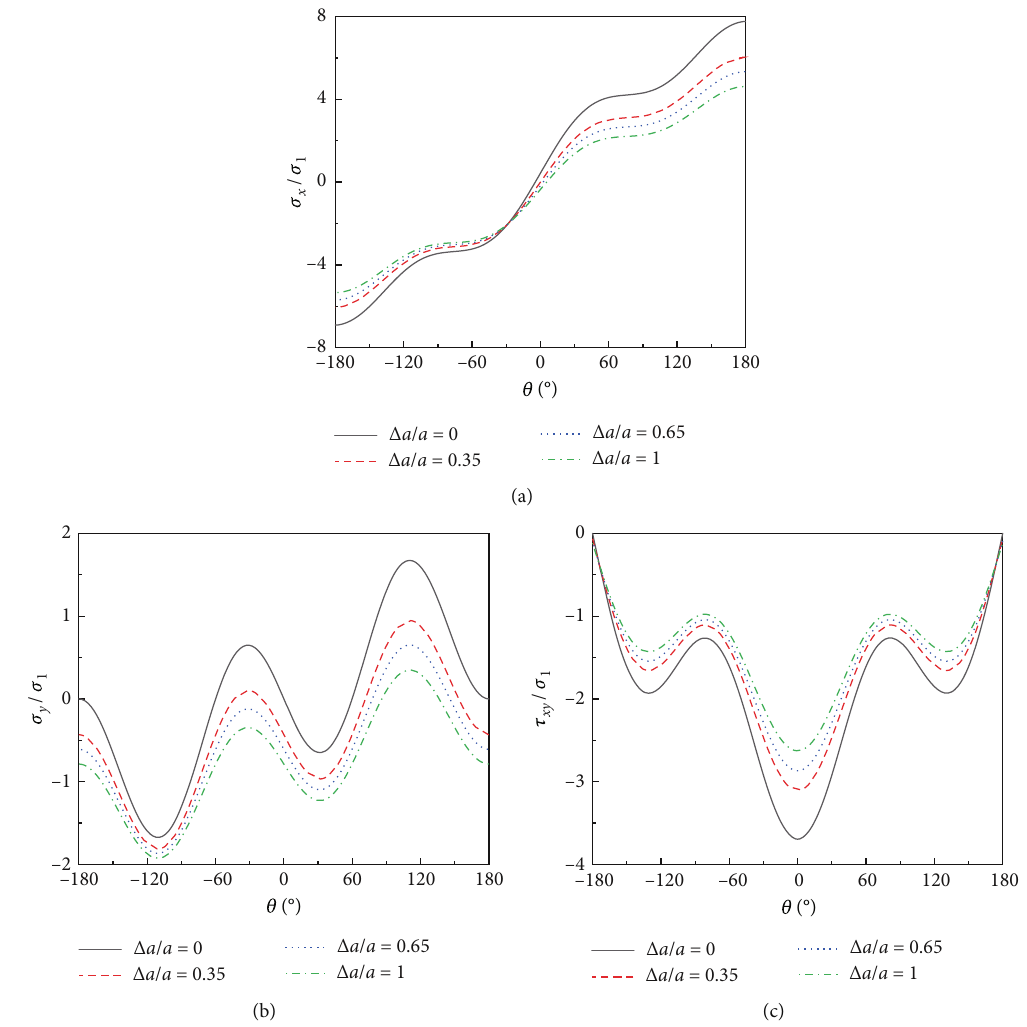
Figure 19: Comparison of normalized stress components on a circle with radius of 0.05mm around the crack tip at di ff erent closures: (a) σ ; and (c) τ . (b) σ y xy